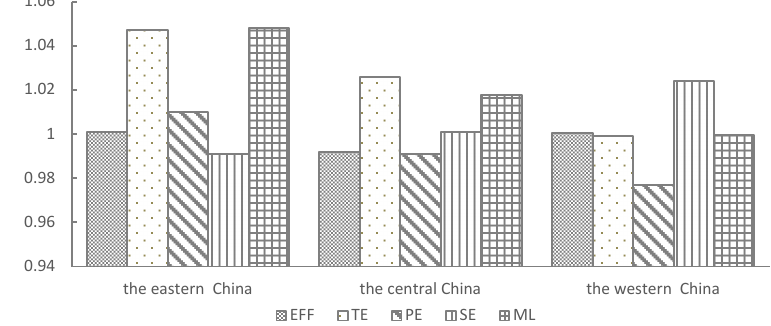
Figure 7. The indices of ML, EFF, PE, SE, and for the three regions in China, 2006 to 2018. Note: Data is calculated and processed from this article.